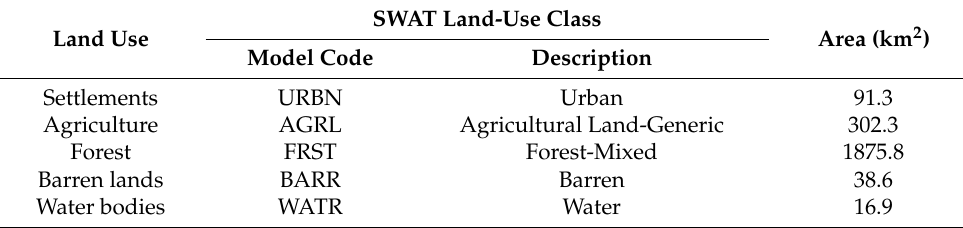
Table 3. Land-use classes in Kelani River Basin (in 1997) and corresponding SWAT codes.